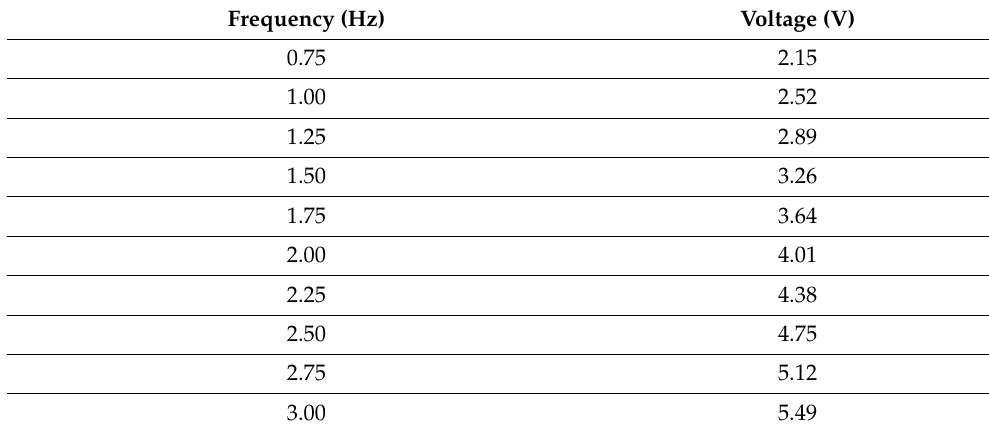
Figure 9. L inear relation between the voltage supplied to the motor and the tail beat frequency. Points are the means of 100 frequency readings. Error bars indicate maximal and minimal values.